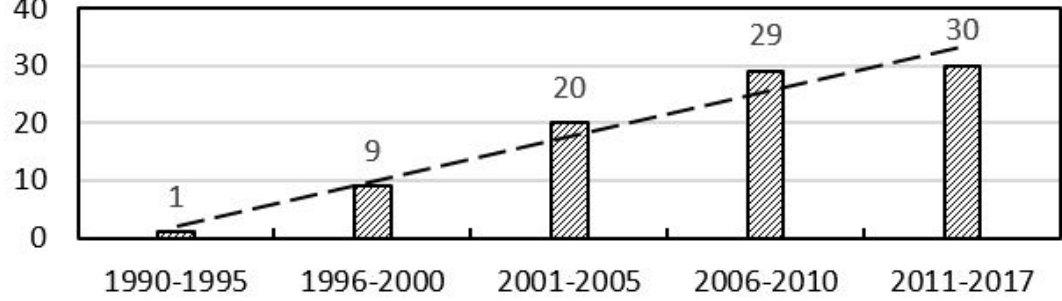
Figure 1. Machine learningrelated papers by year (collected from CumInCAD website).